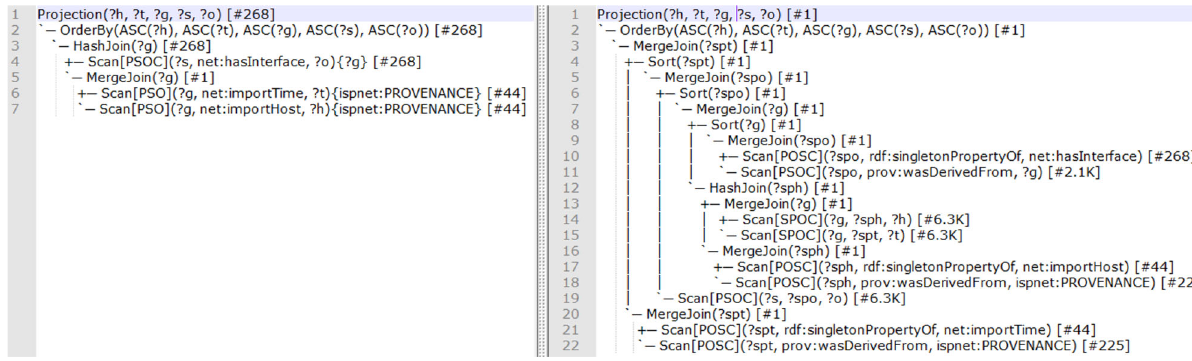
Fig. 2 Query length and complexity comparison based on Query 5 for GraphSource (left) versus singleton property (right)